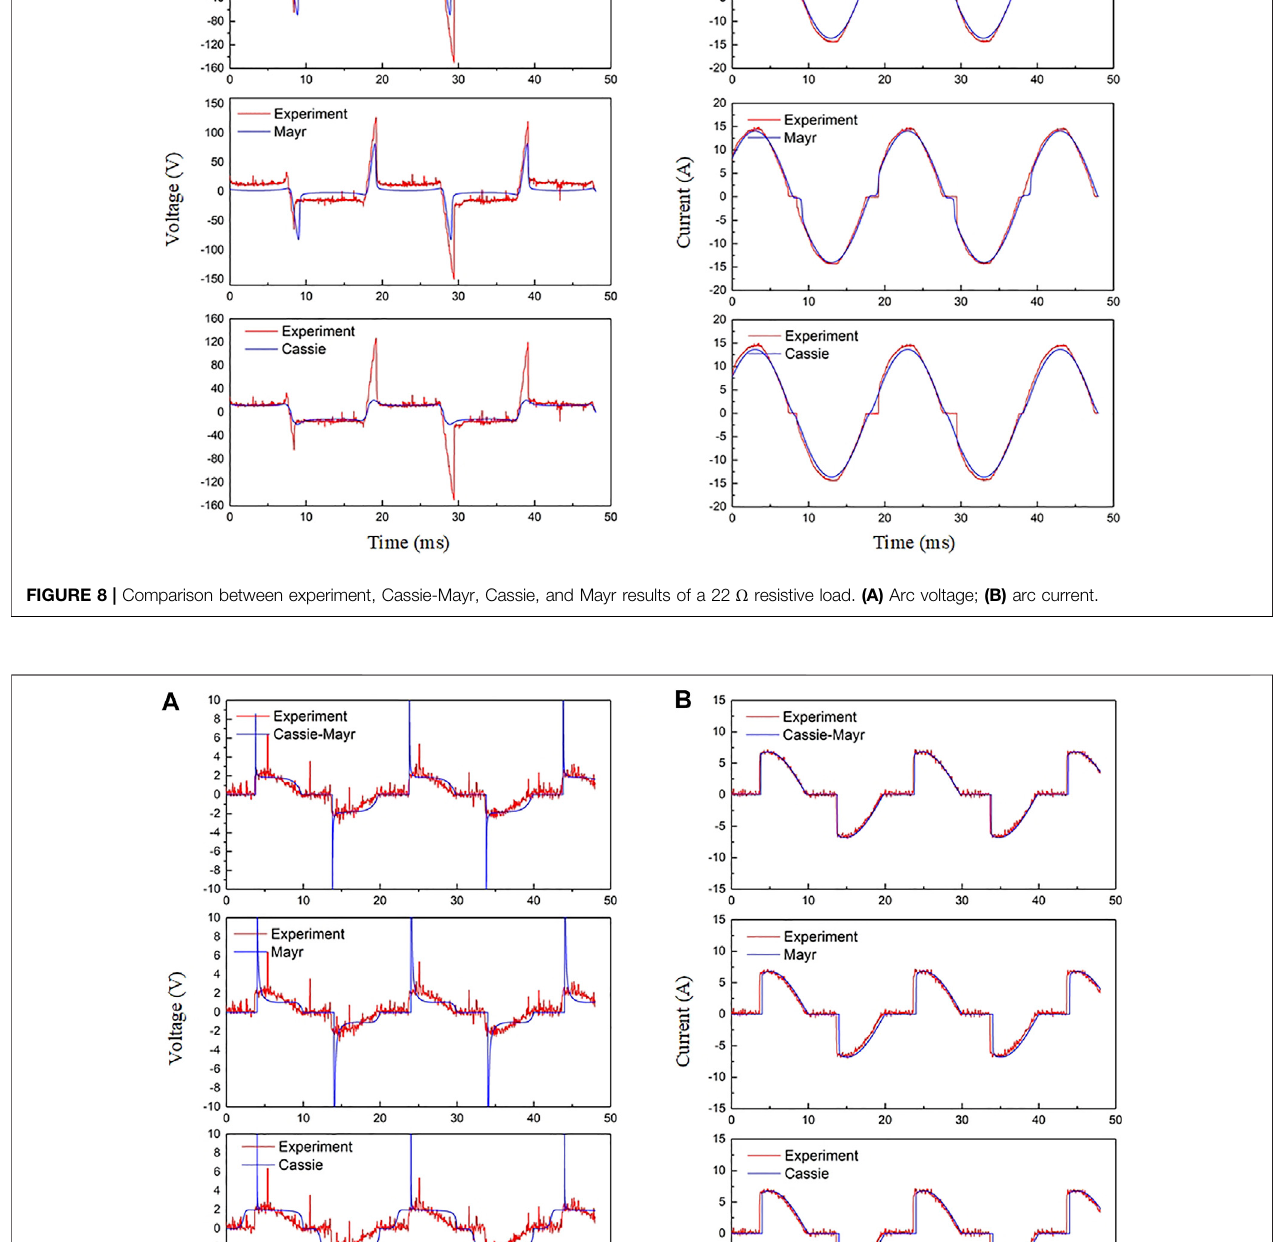
Frontiers in Energy Research |